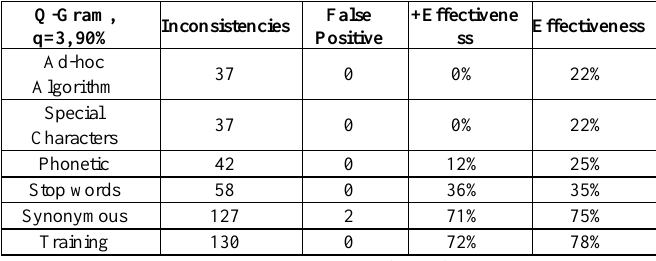
Table 3: Results obtained with data cleaning process using the algorithm Q-Grams, with q=3 and 90% similarity.